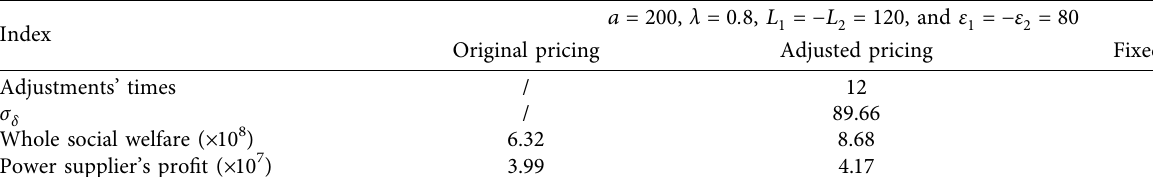
Table 3: Simulation results.